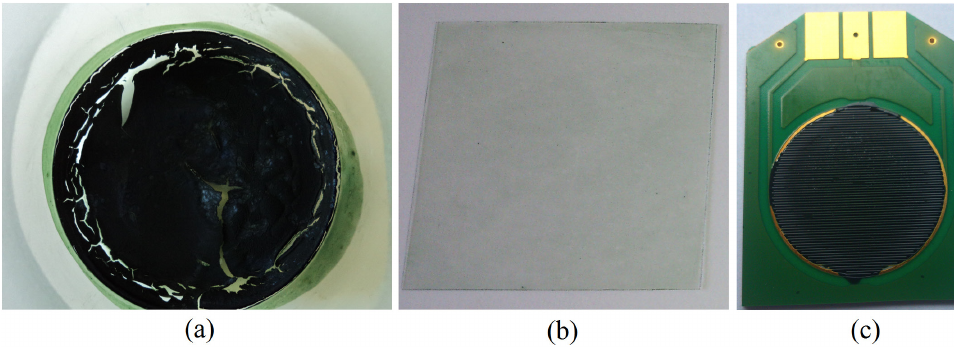
Figure 1: PSSA-PANI complex: (a) dried in bulk, (b) thin film spin coated on glass , (c) deposited on interdigitated electrode.